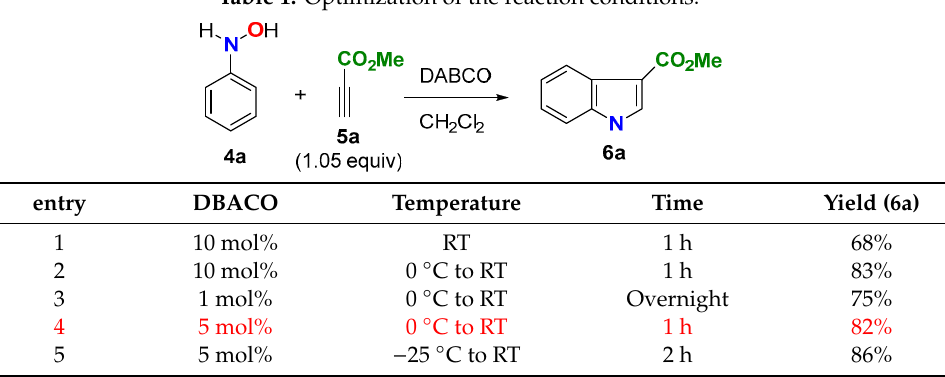
Table 1. Optimization of the reaction conditions.